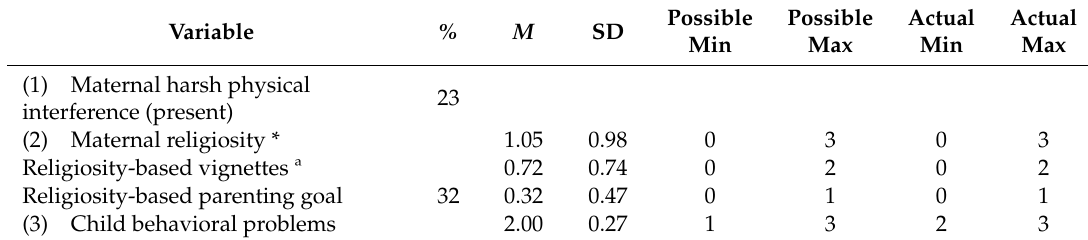
Table 1. Descriptives of maternal harsh physical interference, religiosity variables, and child behavioral problems ( N = 62).